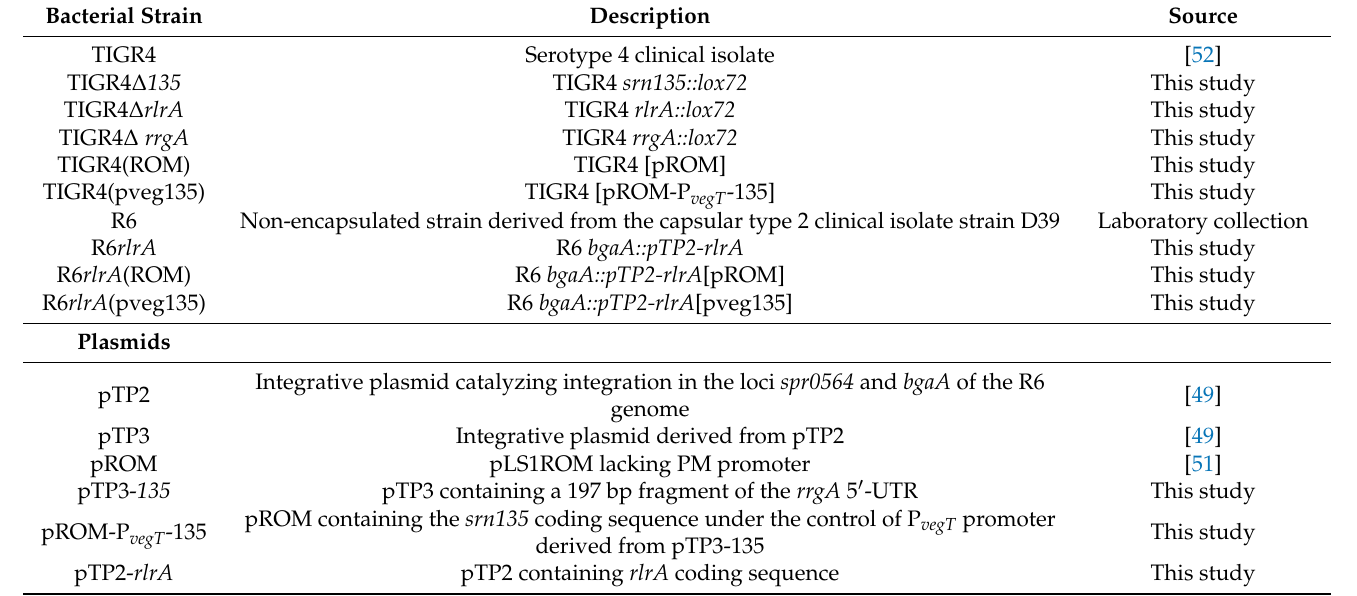
Table 1. Strains and plasmids used in this